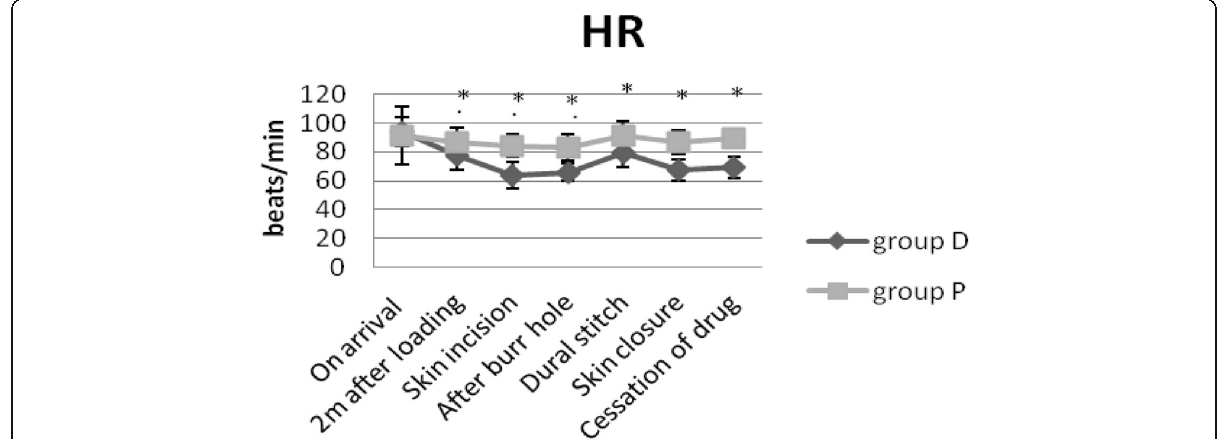
Fig. 1 Changes in HR. Changes in mean values of HR over time. Lines are mean HR and error bars are SD. *Statistical significance between groups